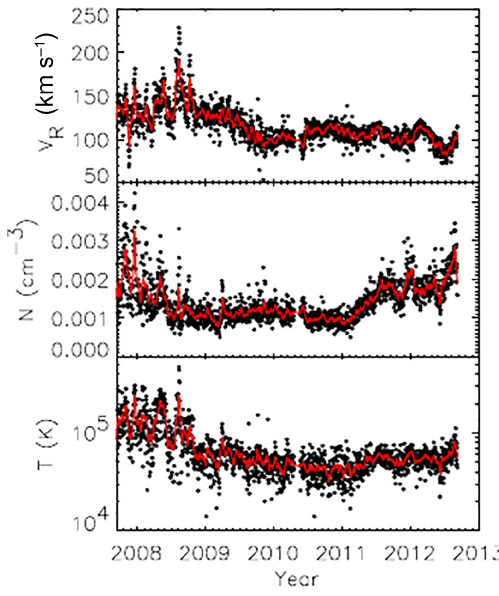
Figure 1. Daily (points) and 11-day running averages (lines) of the radial speed, density, and temperature observed at V2. Taken from Richardson and Wang